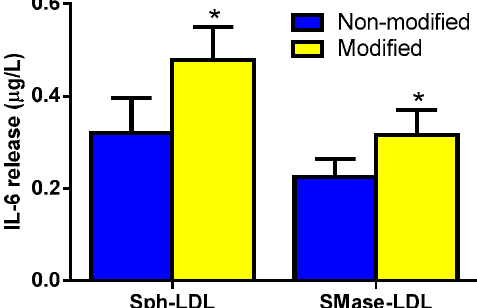
Figure 4. IL-6 release promoted by “in vitro” modified LDL. Monocytes were incubated with unmodified LDL (blue bars) or modified LDL (yellow bars), both at 60 mg apoB/L. LDL was modified by incubation with Sph-enriched liposomes (at 0 and 10 µM) and by sphingomyelinase (SMase) treatment (at 0 and 10 U enzyme/g apoB). After 20 hours of incubation, cytokine release was measured by ELISA. Results are expressed as μ g/L and as mean ± SD ( n = 6), * vs. unmodified LDL, p < 0.05. Next, we sought to determine whether the inhibition induced by MAPP and CPZ on cytokine release was due to a direct e ff ect on LDL( − ) or was a consequence of an e ff ect on cell enzymes. For this purpose, LDL( − ) was pre-incubated with MAPP or CPZ, and then dyalized to remove excess inhibitor prior to its addition to monocytes. This effect was compared to that promoted when monocytes were incubated simultaneously with LDL( − ) and an inhibitor (co-incubation). Figure 5 shows IL-6 release, as a representative cytokine induced by LDL( − ). No signi fi cant di ff erence was